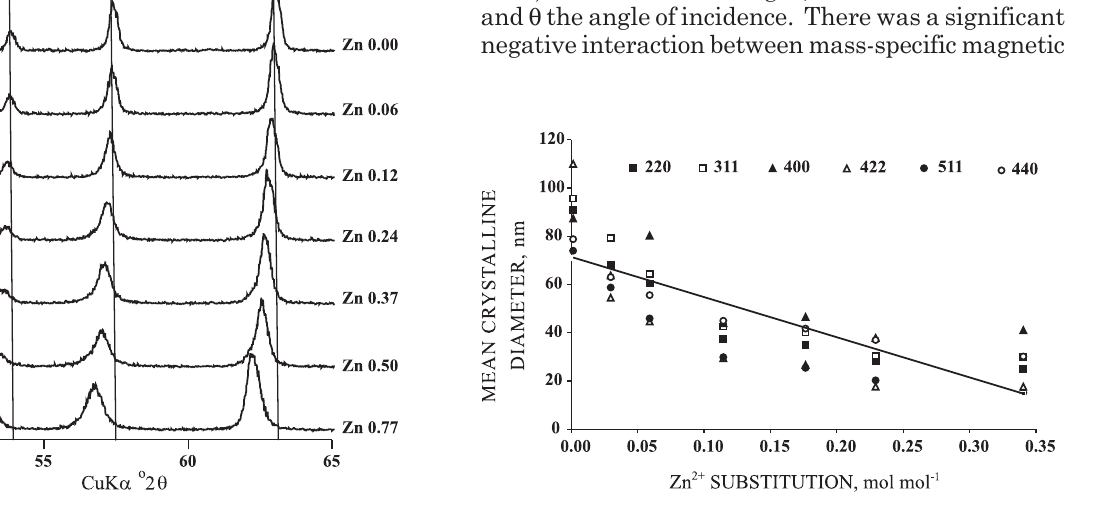
Figure 2. Details of the reflexes 422, 511 and 440 of synthetic maghemites with different zinc isomorphic substitution levels.